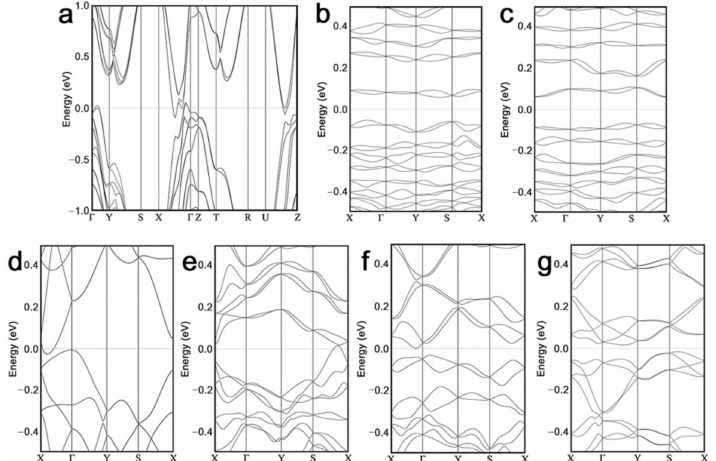
Figure 8. Electronic band structures of ( a ) bulk WTe 2 , ( b ) 1 L W 8 Te 18 O 5 (W:Te = 1:2.25), ( c ) 1 L W 8 Te 14 O 9 (W:Te = 1.75), ( d ) 1 L W 16 Te 32 (W:Te = 1:2), ( e ) 1 L W 15 Te 32 (W:Te = 1:2.13), ( f ) 1 L W 16 Te 30 (W:Te = 1:1.875) and ( g ) 1 L W 16 Te 26 (W:Te = 1:1.625). Reprinted with permission from